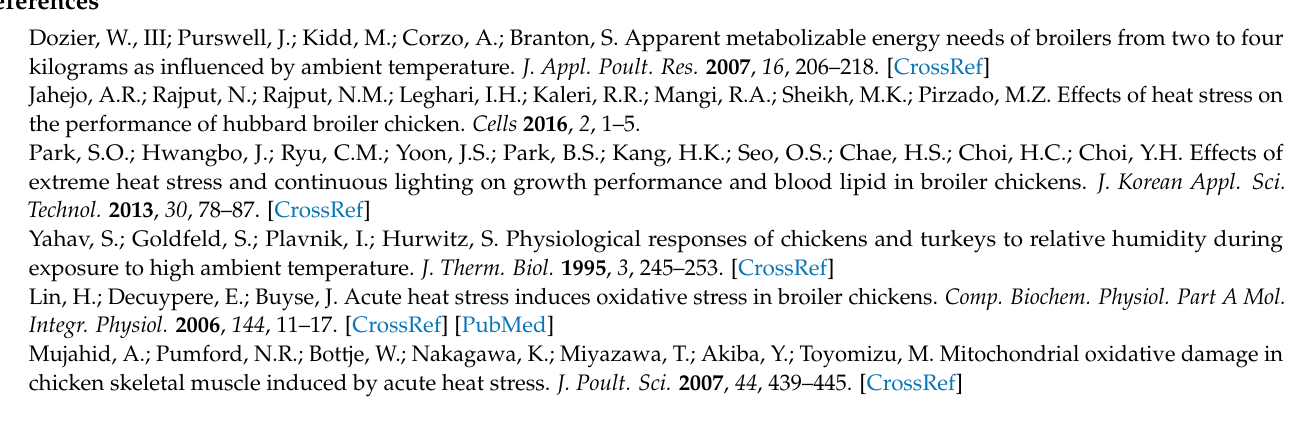
qPCR; Table S3: Differentially expressed proteins by acute heat stress compared to control; Table S4: Relieved expression proteins by early heat exposure under acute heat stress; Table S5: GO terms of genes encoded alleviated proteins by early heat exposure under acute heat stress; Table S6: KEGG pathways of genes encoded differentially expressed proteins by acute heat